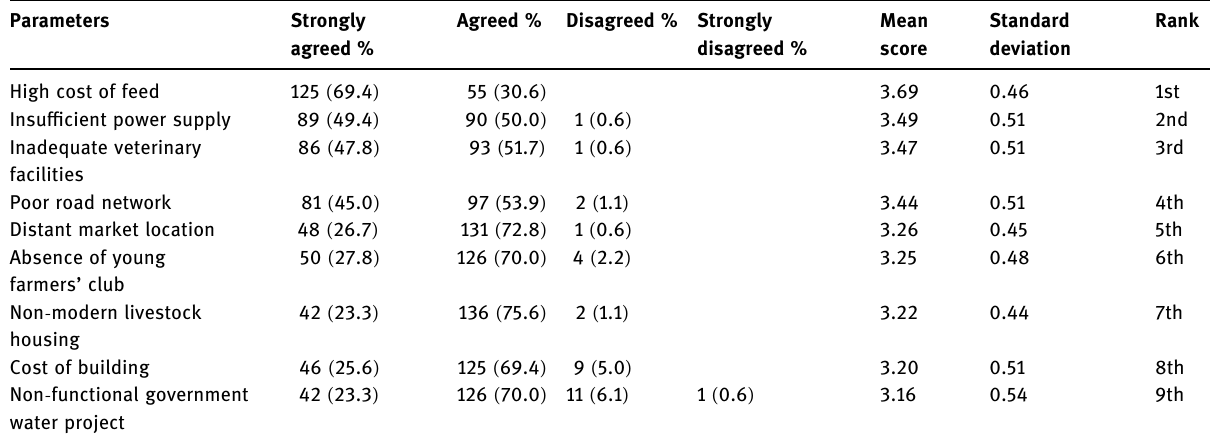
Table 7: Respondents ’ perceptions of the challenges faced by livestock development practitioners Parameters